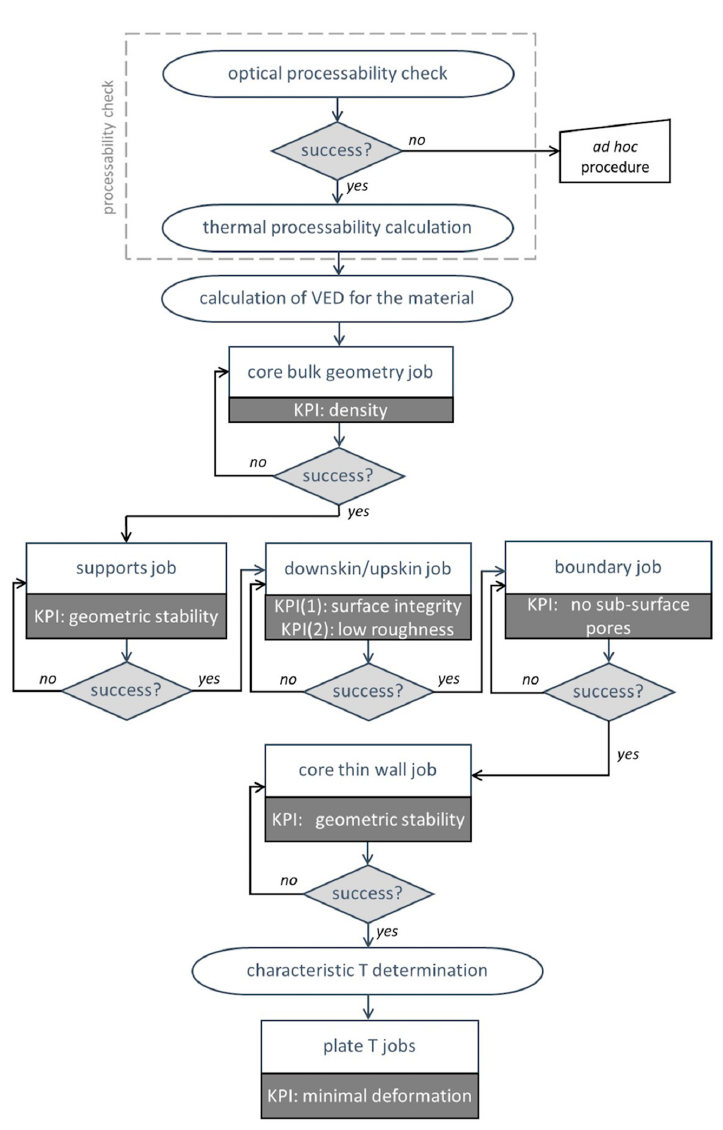
Figure 1. Flowchart showing the key points of the proposed optimization procedure. VED, volume energy density; KPI, key performance indicator.